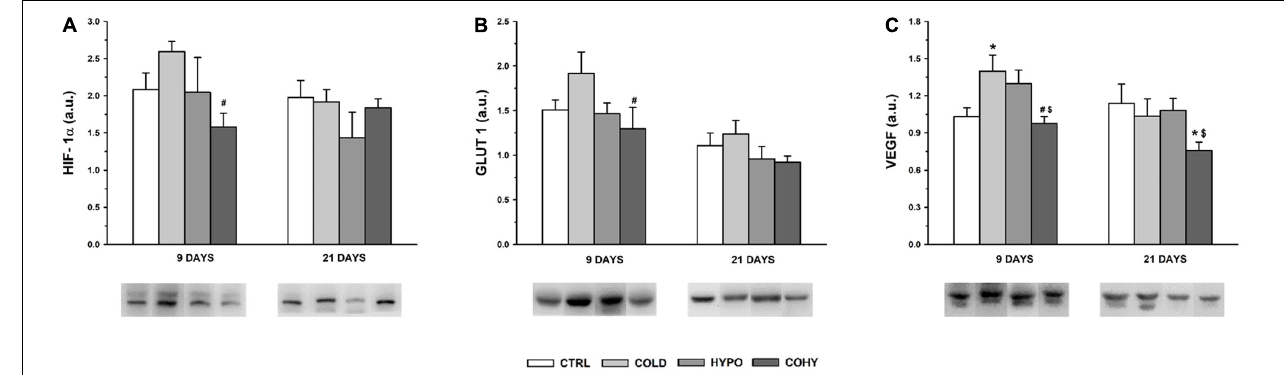
FIGURE 8 | Hypoxia-inducible factor 1 α (HIF-1 α ) signaling pathway protein expression in gastrocnemius muscle after 9 and 21 days. (A) HIF-1 α ; (B) glucose transporter 1 (GLUT 1); (C) vascular endothelial growth factor (VEGF). CTRL, control; COLD, intermittent cold; HYPO, intermittent hypoxia; COHY, intermittent cold + hypoxia. Data are presented as mean ± standard error and expressed in arbitrary units (a.u.). Statistically significant differences are indicated as follows: * p < 0.05 vs. CTRL, # p < 0.05 vs. COLD, $ p < 0.05 vs. HYPO. Sample size: n = 6 per group at each temporal time